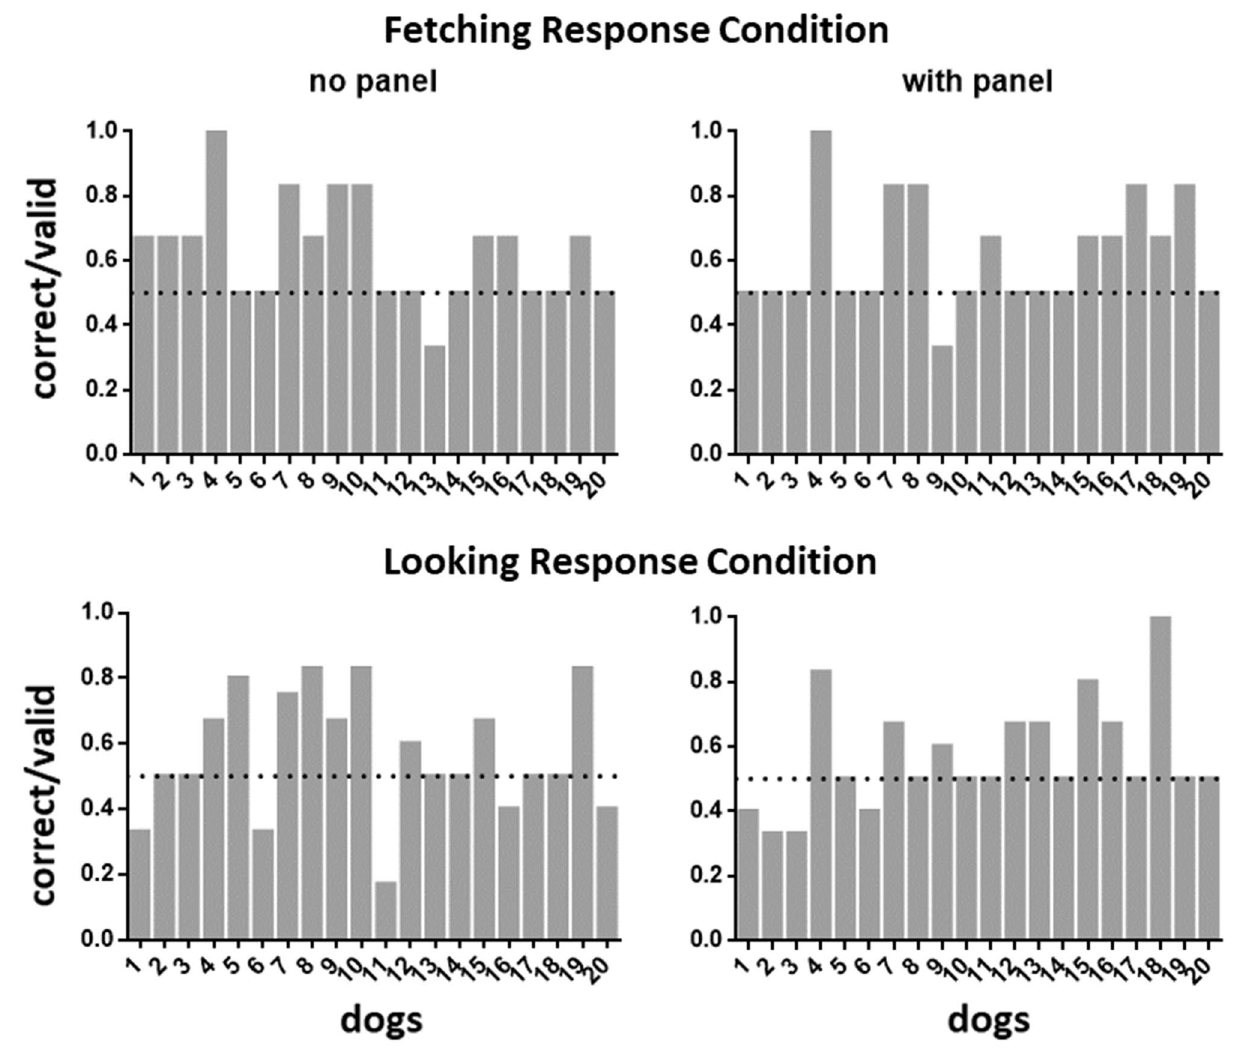
Figure 2. Overview of the proportion of correct choice trials (divided by total number of valid trials, dotted line indicates chance level) for each of the 20 dogs in both response conditions, with and without the